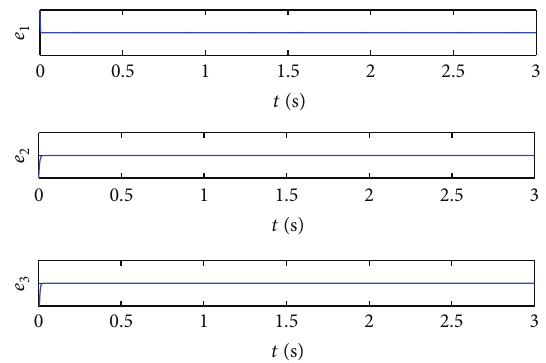
Figure 3: Synchronization error of the response system (53) and the diver system